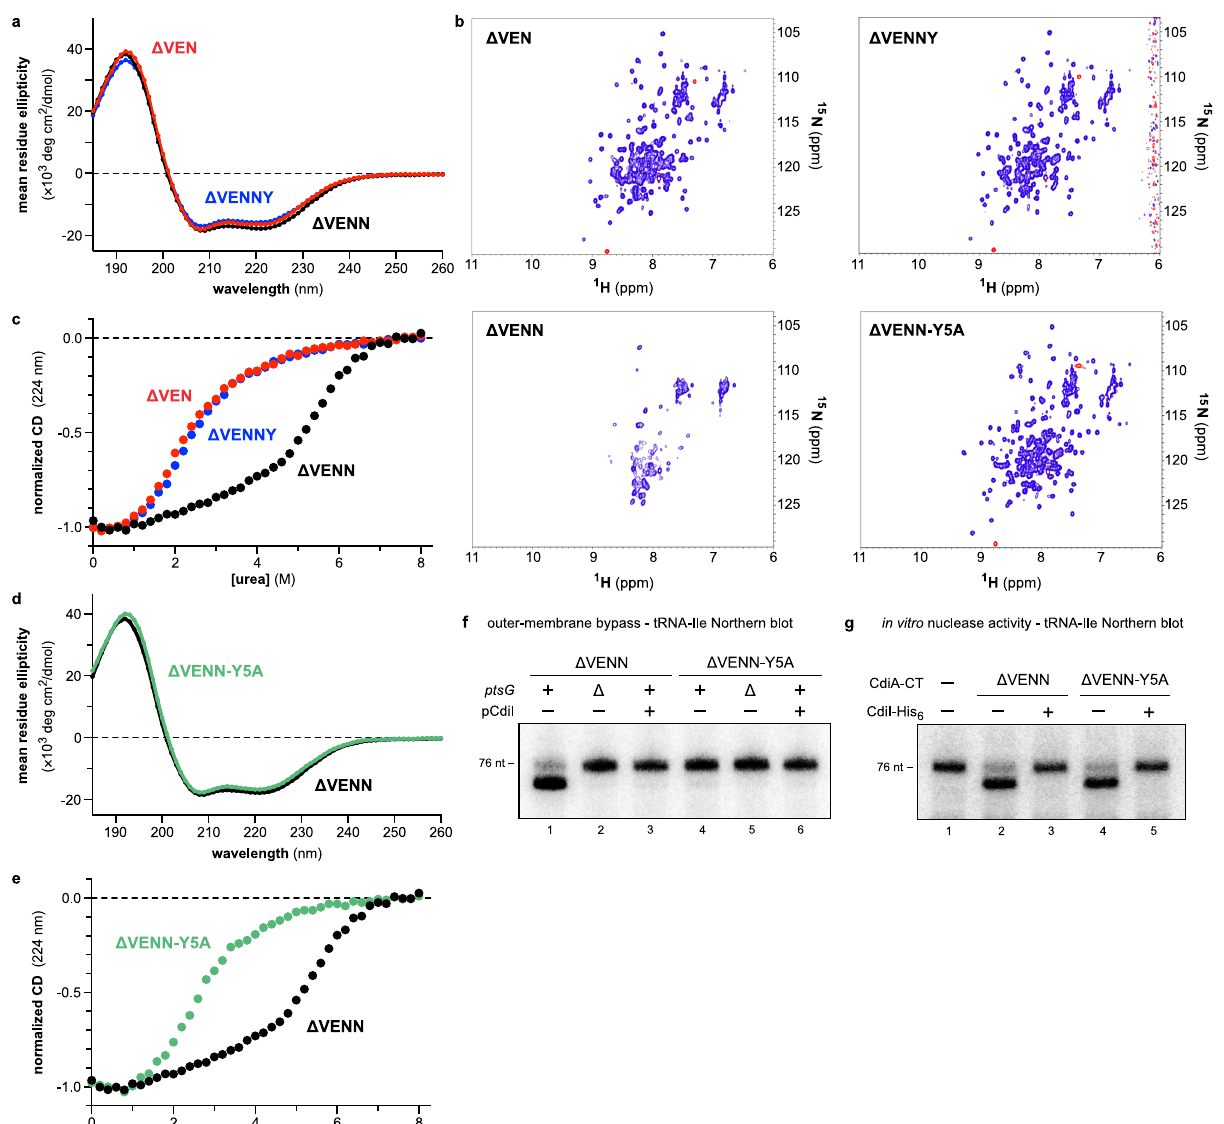
Fig. 4 | The N-terminus of the PtsG-dependent entry domain controls a con- formationalswitch.a CDspectraofPtsG-dependententrydomains. b 1 H- 15 NHSQC NMR spectra of PtsG-dependent entry domains. c Chemical denaturation of PtsG- dependent entry domains. Puri fi ed proteins were denatured in urea and unfolding monitored by CD at 224nm. d CD spectra of Δ VENN and Δ VENN-Tyr5Ala entry domains. e Chemical denaturation of Δ VENN and Δ VENN-Tyr5Ala entry domains. f Outer-membrane bypass. Puri fi ed CdiA-CT EC3006 variants were incubated with